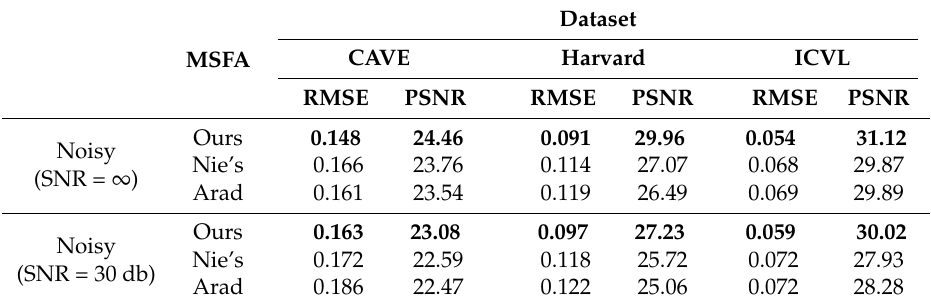
Table 3. Quantitative evaluation of the deep-learning-based reconstructions using Fu’s, Arad’s and our MSFA (see Figure 7) on synthetic